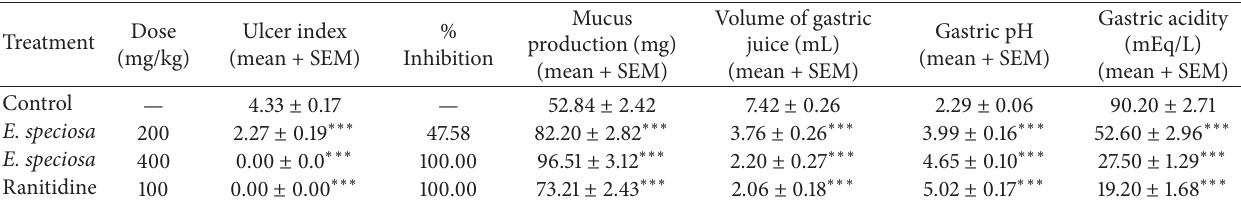
Table 7: Effects of orally administered aqueous extract of E. speciosa on gastric ulceration and secretion in rats submitted to the augmented histamine test.